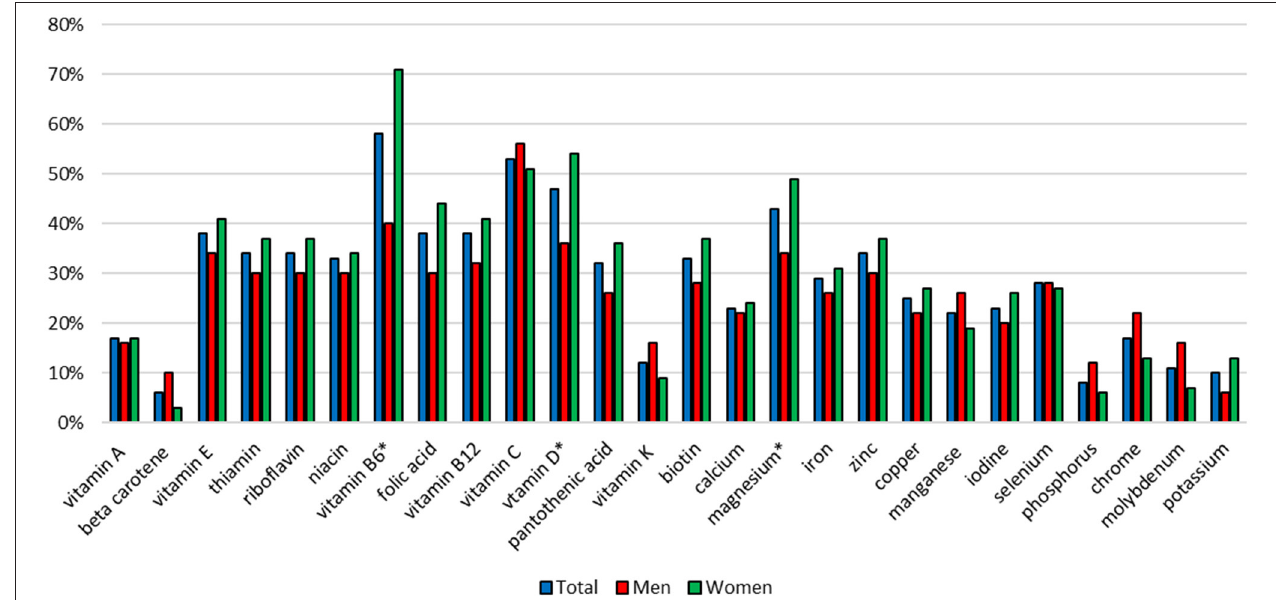
FIGURE 3 | Percentage of subjects supplementing particular vitamins and minerals. *statistically significant difference, chi-square test, p < 0.05.